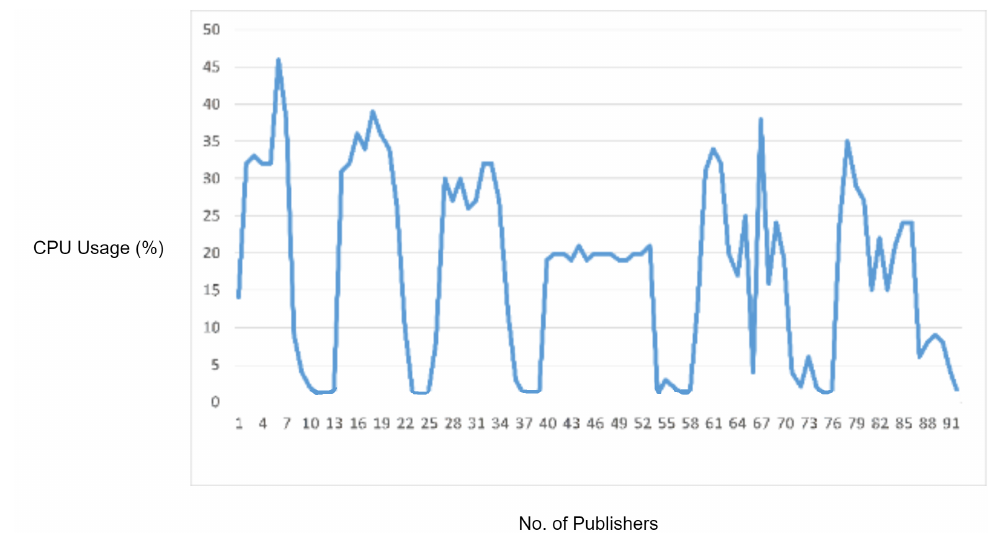
Figure 11. CPU usage captured while testing the required field check